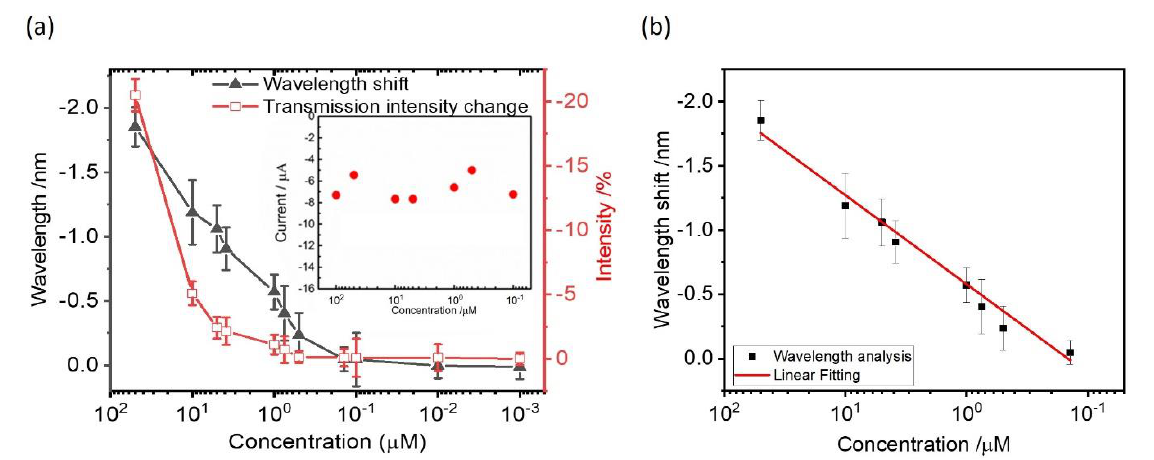
Figure 6. ( a )The wavelength shifts and the transmission intensity changes of gold nanoslit arrays against Hg 2+ concentrations between 100 µ M and 1 nM. The inset shows the reduction reaction currents of amperometric responses at various Hg 2+ concentrations. ( b ) The measured wavelength shifts against the logarithm of the Hg 2+ concentration. The measured points are fitted with a red line in the semi-log plot. The fitting equation is ∆ SPR signal (nm) = − 0.69 log (C) − 4.7 with a correlation coefficient of R 2 = 0.98, where C is the molar concentration (M) of Hg ions.